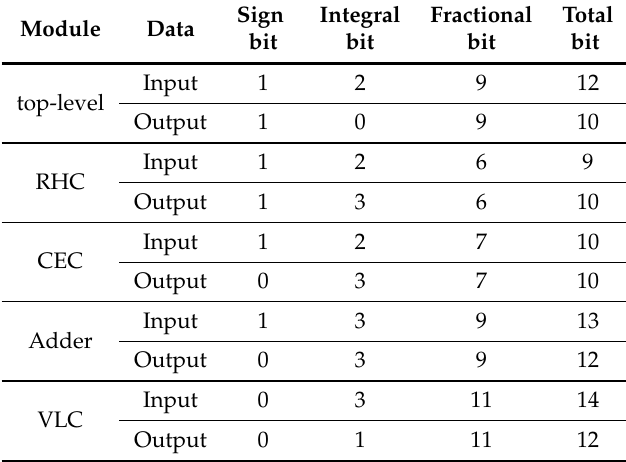
Table 7. Word Length